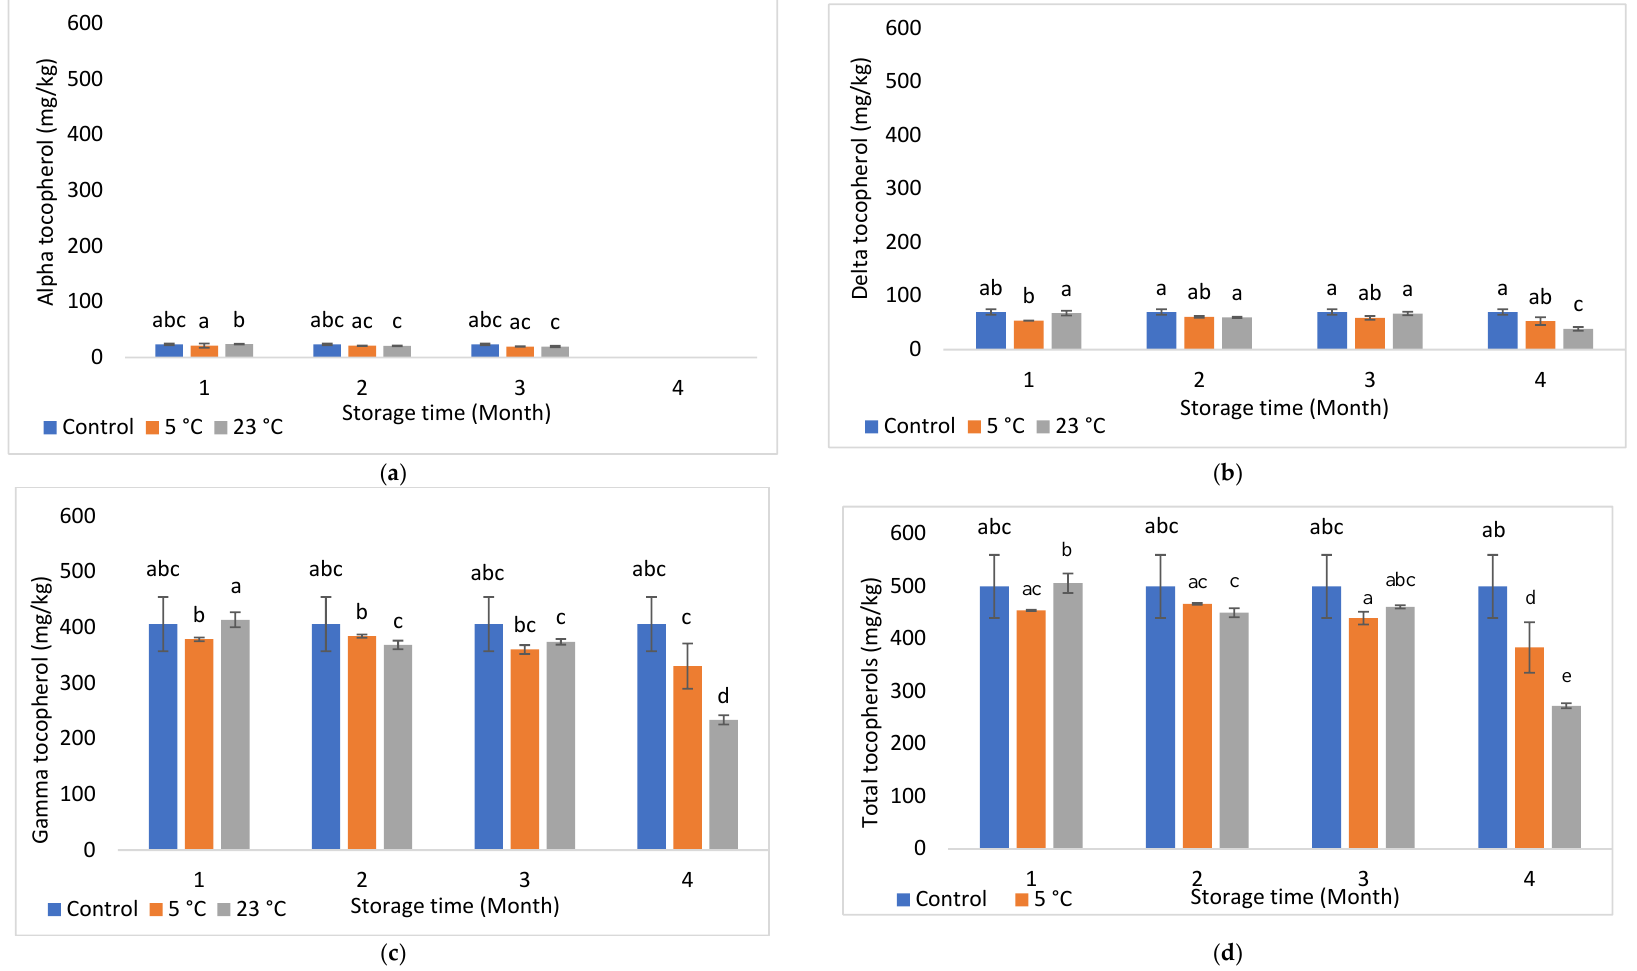
Figure 2. ( a – d ) Changes in alpha ( a ), delta ( b ), gamma ( c ), and total tocopherol ( d ) contents of Chandler oil along storage. Different letters within indicate significant differences ( p < 0.05) for storage time and month.